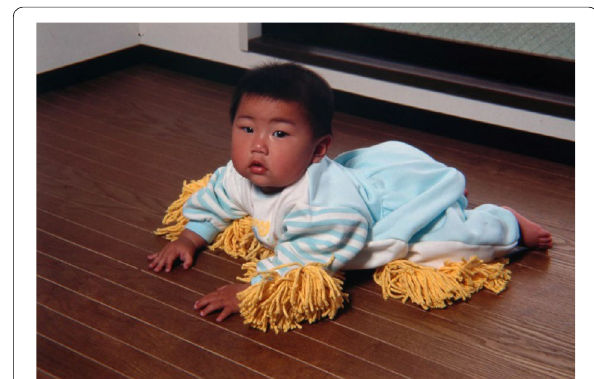
Fig. 3 The baby mop. Source: https ://www.tofug u.com/japan /chind ogu-japan ese-inven tions /